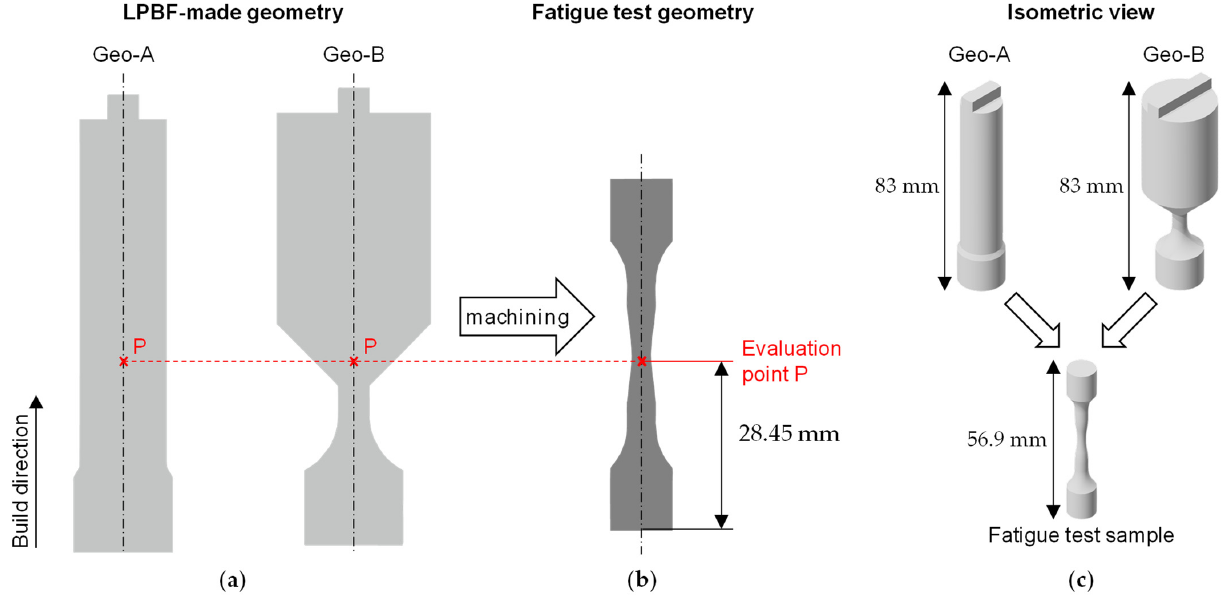
Figure 2. Methodology for local evaluation of geometry effect on microstructure and fatigue strength at evaluation point P, ( a ) LPBF-made geometry Geo-A and Geo-B, ( b ) Uniform fatigue test geometry after machining of Geo-A and Geo-B, ( c ) Isometric view of sample designs in LPBF-made condition and after machining in fatigue test geometry.